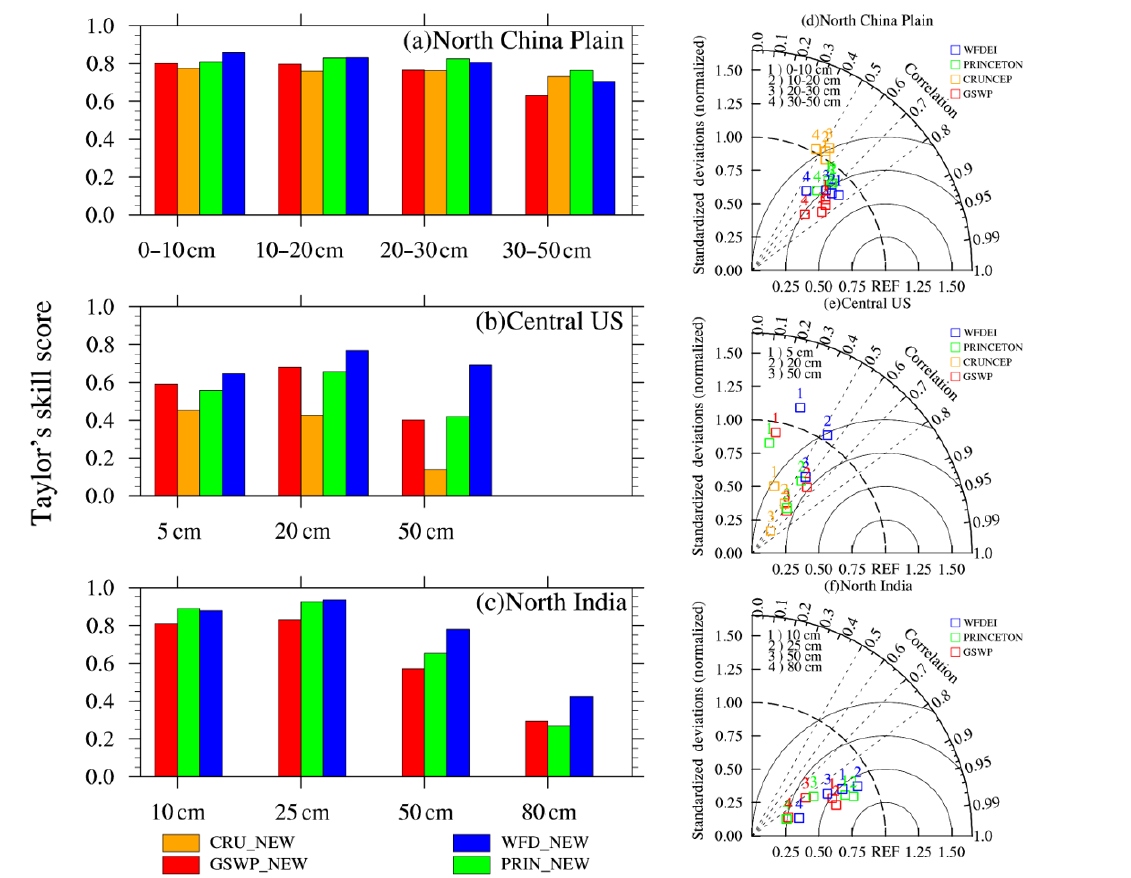
Figure 4. Taylor’s skill scores and Taylor diagrams illustrating the comparisons among GSWP, CRUNCEP, PRINCETON, WFDEI, and in situ observations. (a, d) North China Plain; (b, e) Colorado in the central US; (c, f) northern India. The azimuthal angle represents the correlation coefficient, and radial distance is the standard deviation normalized to